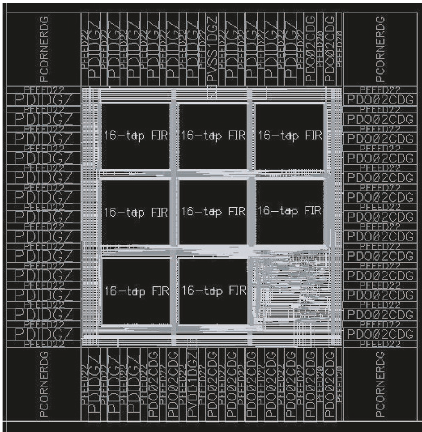
Figure 10: Layout of the proposed 128-tap programmable FIR pro-